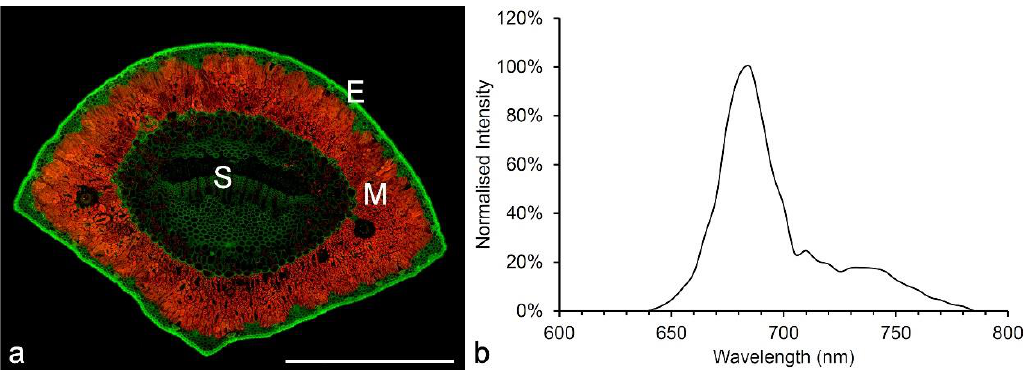
Figure 2. Autofluorescence of chlorophyll in leaves. ( a ) A transverse section ( TS) of a pine needle showing autofluorescence of chlorophyll (red) in the mesophyll tissue (M) (excitation at 488 and 561 nm, emission at 500 – 569, 570 – 700 nm). The bright green fluorescence in the epidermis (E) originates from flavonoids bound to the cell wall, while the weaker green fluorescence in the stele (S) represents lignin. Scale bar = 500 µm. ( b ) The fluorescence spectrum of pine chlorophyll (excitation at 561 nm, emission at 600 – 800 nm) [15].